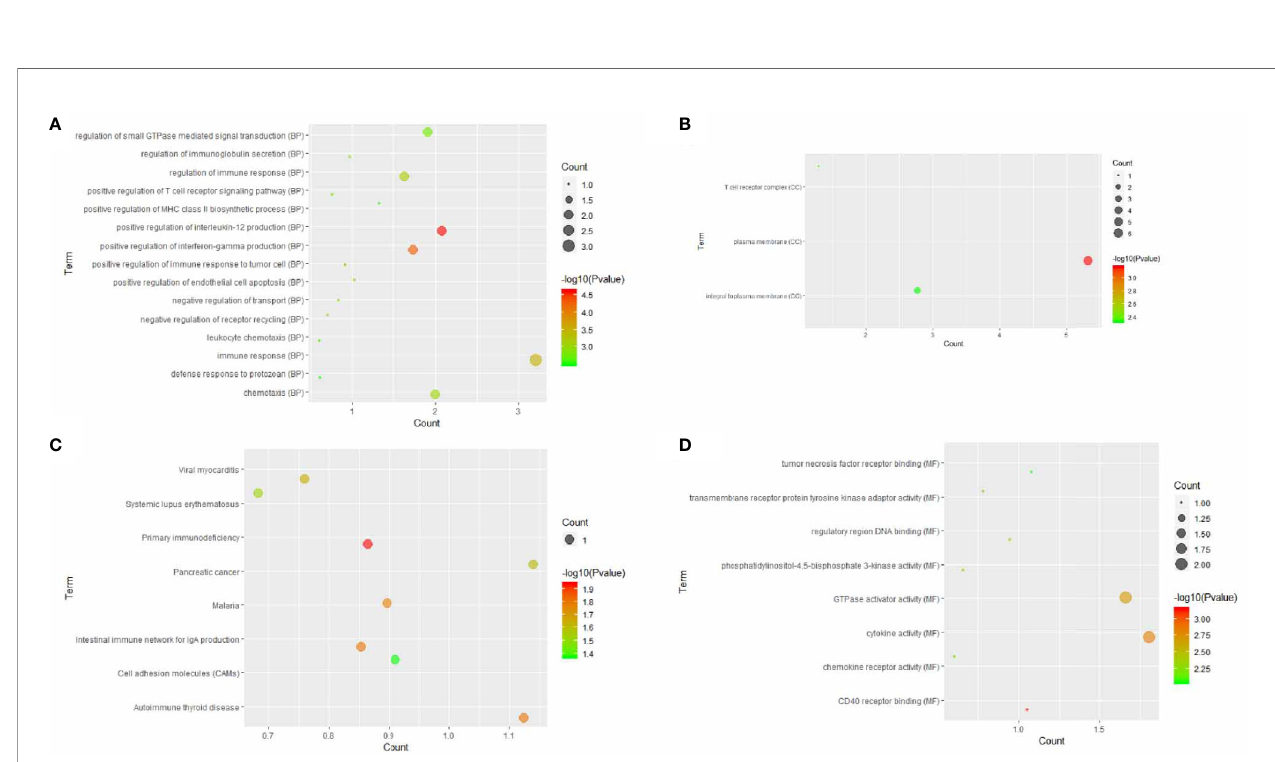
FIGURE 5 | GO terms or KEGG pathways of similar genes of CLEC9A. The x -axis shows − log p , and the y -axis shows GO terms or KEGG pathways. (A) Biological process. (B) Cellular component. (C) Molecular function. (D) KEGG